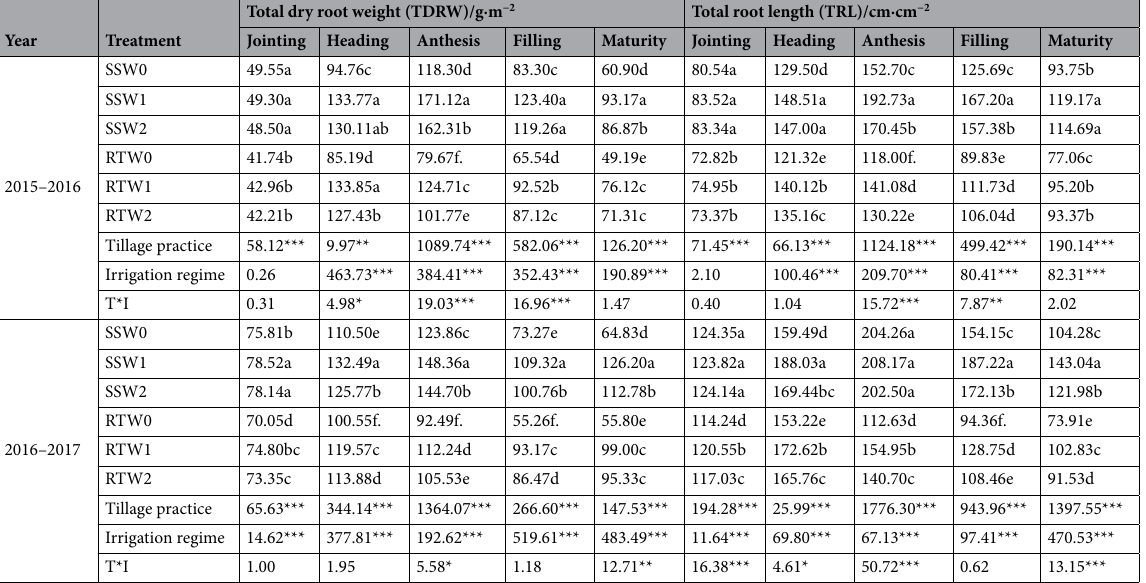
Table 2. Effects of tillage practice and irrigation regime on the total dry root weight and total root length of winter wheat.